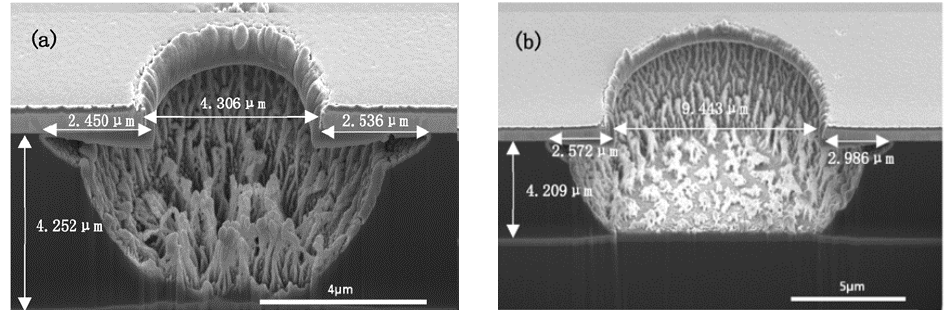
Figure 8. ICP etching of partially cured PI under 2500 W ICP power, 500 W RF power, 10% CHF 3 ratio, 100 sccm gas flow and 2 min. (( a ) the via diameter is 4 µ m; ( b ) the via diameter is 9 µ m).